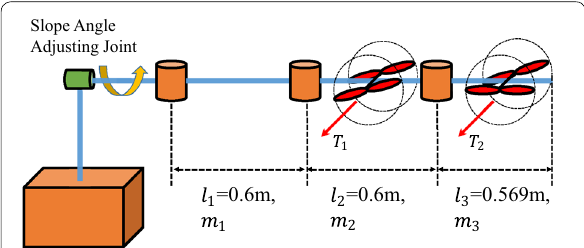
Fig. 3 PIA and the attachment style of the flying watches for future physical